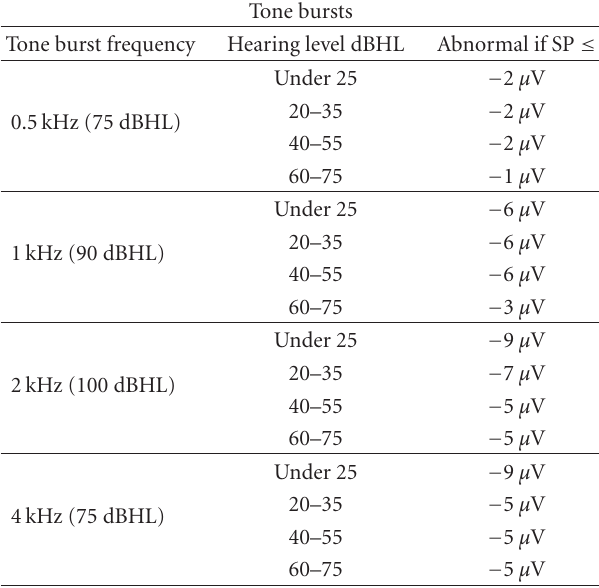
the thresholds measured at 0.5, 1, and 2 kHz for each ear. Table 3: Electrocochleography criteria [27]. The diagnostic level was chosen as the nearest whole figure to the level which provides a false-positive diagnosis rate of 5%. The likelihood of hydrops is a Gibson score of > 7/10 [6]. Clicks: abnormal if SP/AP ratio ≥